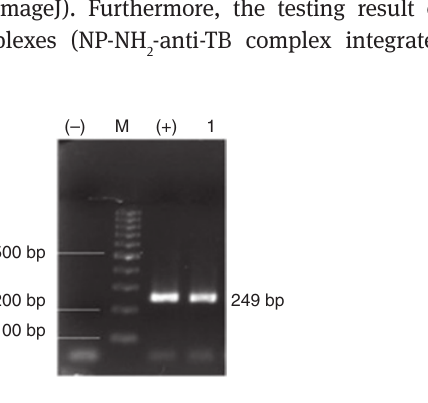
-anti-TB complex activities presented in wastewater. Figure 4: NP-NH 2 (–); M; ( + ): negative control, 100-bp marker, and positive control. Lane 1: NP-NH -anti-TB complex enriched in wastewater 2